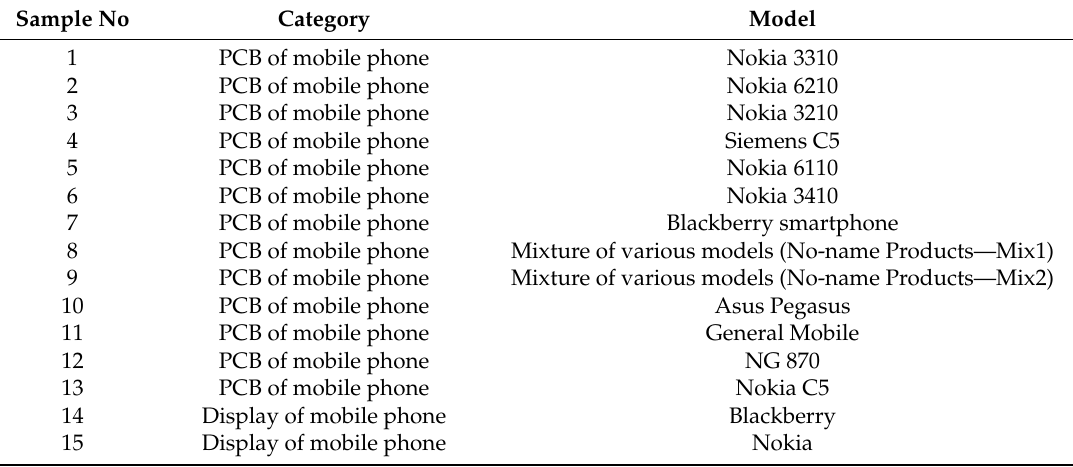
Table 2. Specifications of WEEE samples used in the